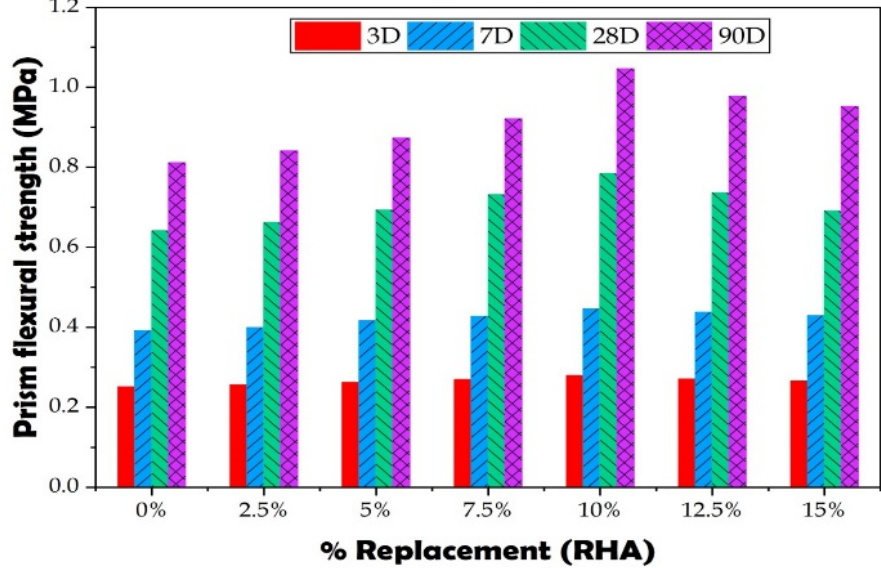
Figure 9. Flexural strength of aerated concrete.